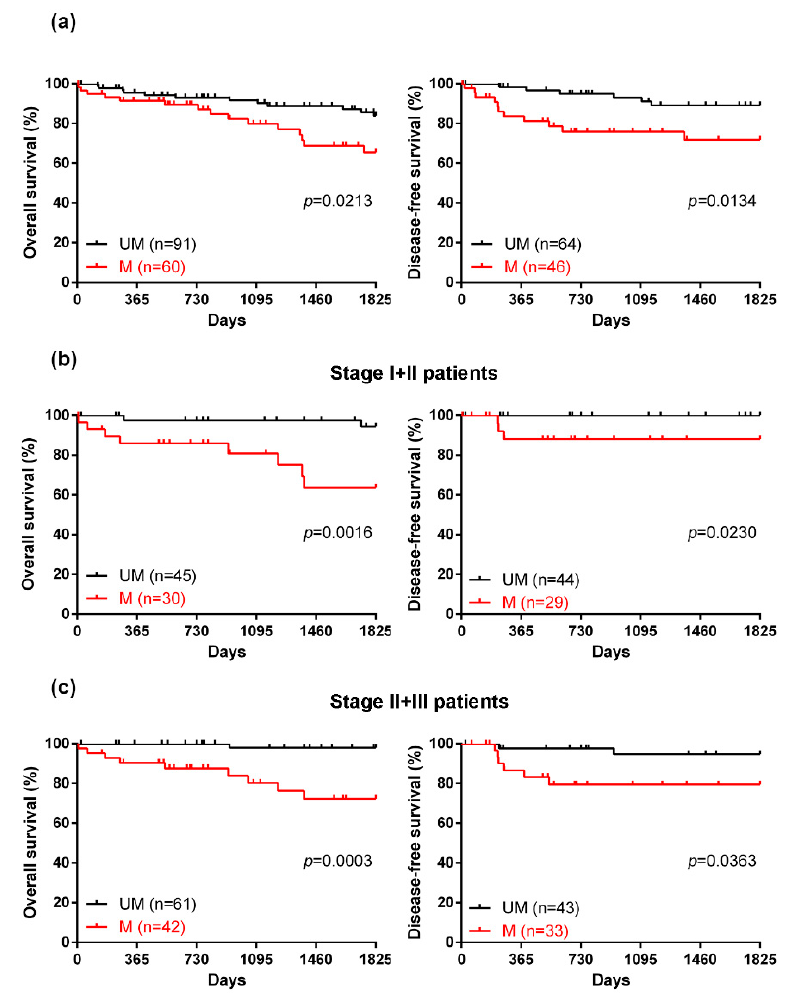
Figure 3. Correlation analysis between the four-gene methylation panel and the survival of CRC patients. ( a ) The 5-year overall survival and disease-free survival rates of CRC patients according to the methylation status are presented. Red line: methylated cases discriminated by the four-gene methylation panel; black line: unmethylated cases. ( b ) The 5-year overall survival and disease-free survival rates of stage I and II CRC patients. ( c ) The 5-year overall survival and disease-free survival rates of stage II and III CRC patients. Table 3. The associations between the four-gene methylation panel and clinicopathological characteristics in 151 CRC patients.